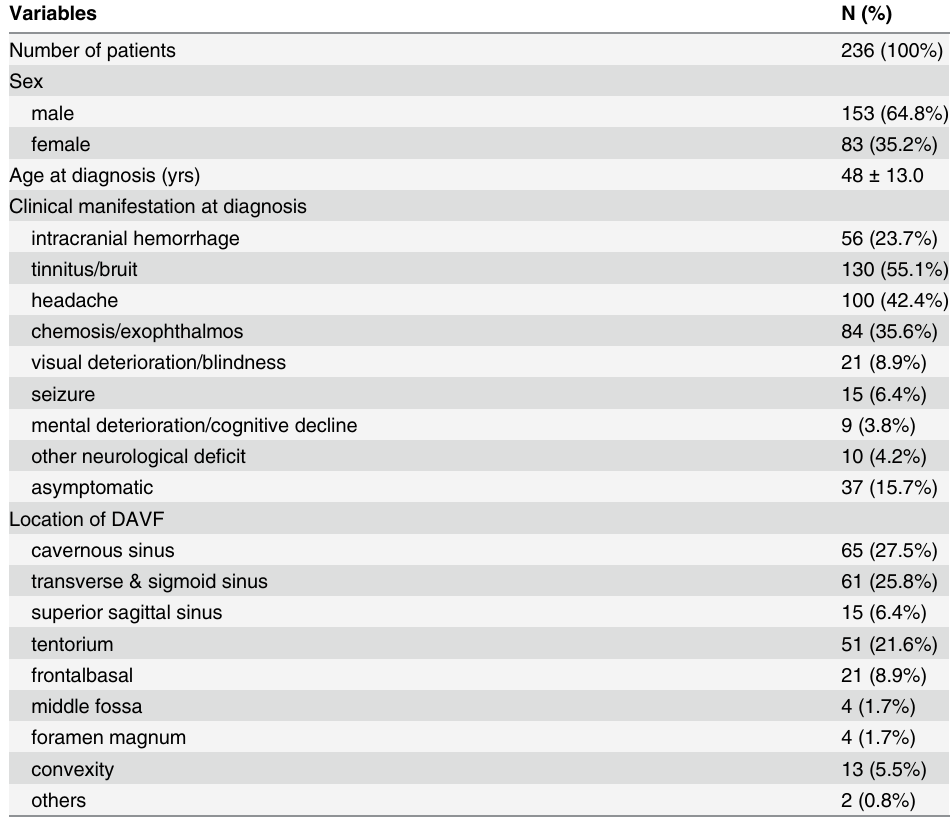
Table 2. Demographic and clinical features of patient